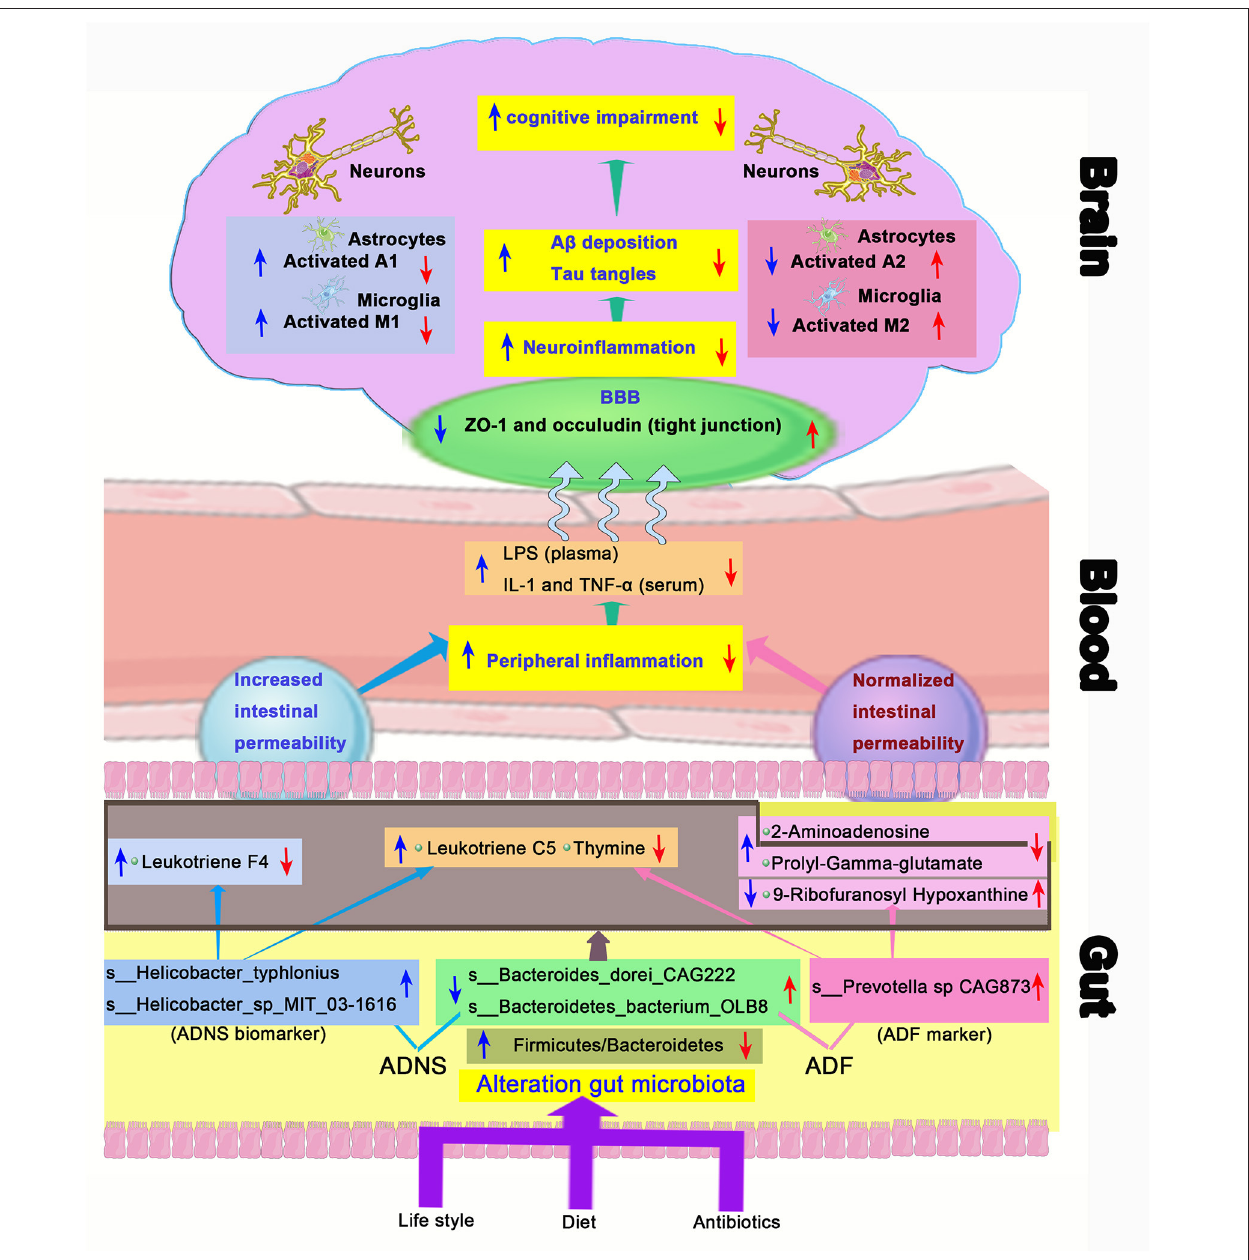
FIGURE 9 | Schematic diagram of the gut-brain axis in AD treated with or without fasudil. Changes in the gut microbiota in the mouse model of AD (ADNS) cause abnormal production of metabolites, which aggravate peripheral inflammation, leading to increases in the brain infiltration of immune cells. Microglia M1 and astrocytes A1 cells are then activated in the brain, resulting in A β deposition, tau phosphorylation, and cognitive impairment. Treatment with fasudil (ADF) reconditions the gut microbiota, normalizes disordered metabolites, reduces the peripheral immune cell infiltration to the brain, ameliorates neuroinflammation, and lowers the accumulation of A β deposition and pTau, leading to ultimate improvement of cognitive functions. Blue arrows represent ADNS-related changes, while the red arrows refer to ADF-related changes. BBB, blood brain barrier; LPS, lipopolysaccharide; IL-1, interleukin-1; TNF- α , tumor necrosis factor - α ; ZO-1, zonula occluden-1.